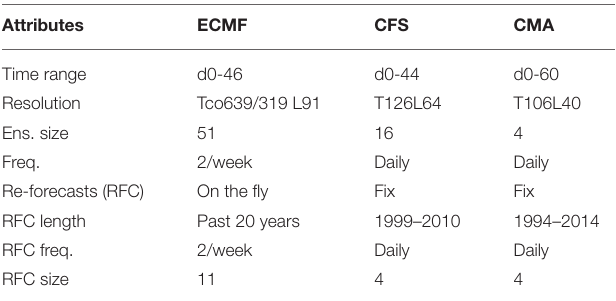
TABLE 1 | ECMWF, NCEP, and CMA forecasts attributes as archived in the Subseasonal-to-seasonal (S2S) database at ECMWF.